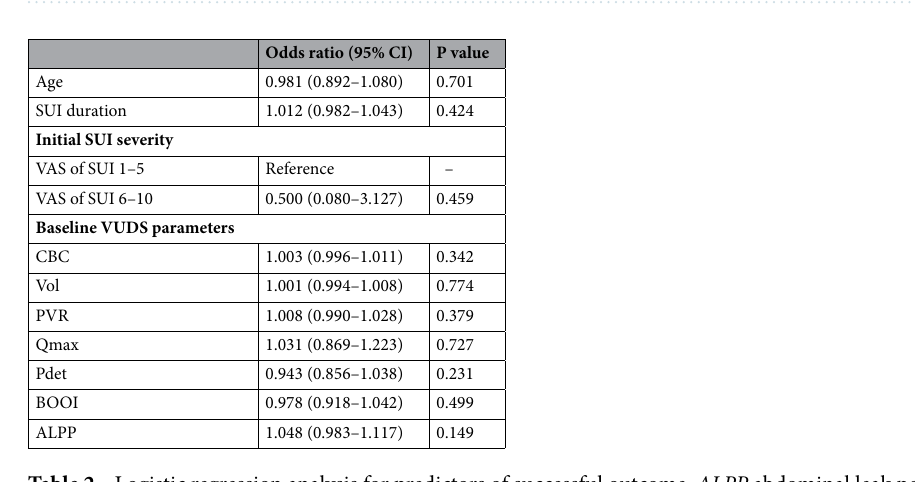
Figure 1. The changes in stress urinary incontinence (SUI) severity as per the visual analogue scale of SUI after autologous platelet-rich plasma urethral sphincter injections ( a ) in all patients; ( b ) Subgroup analysis by outcome.